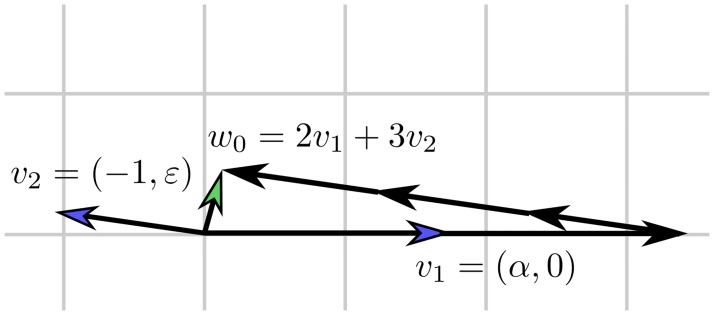
Which element of the lattice generated by the above two blue headed vectors is closest to the origin? Or in other words, what is the shortest nonzero vector which can be obtained as an integer coefficient linear combination of the above vectors?